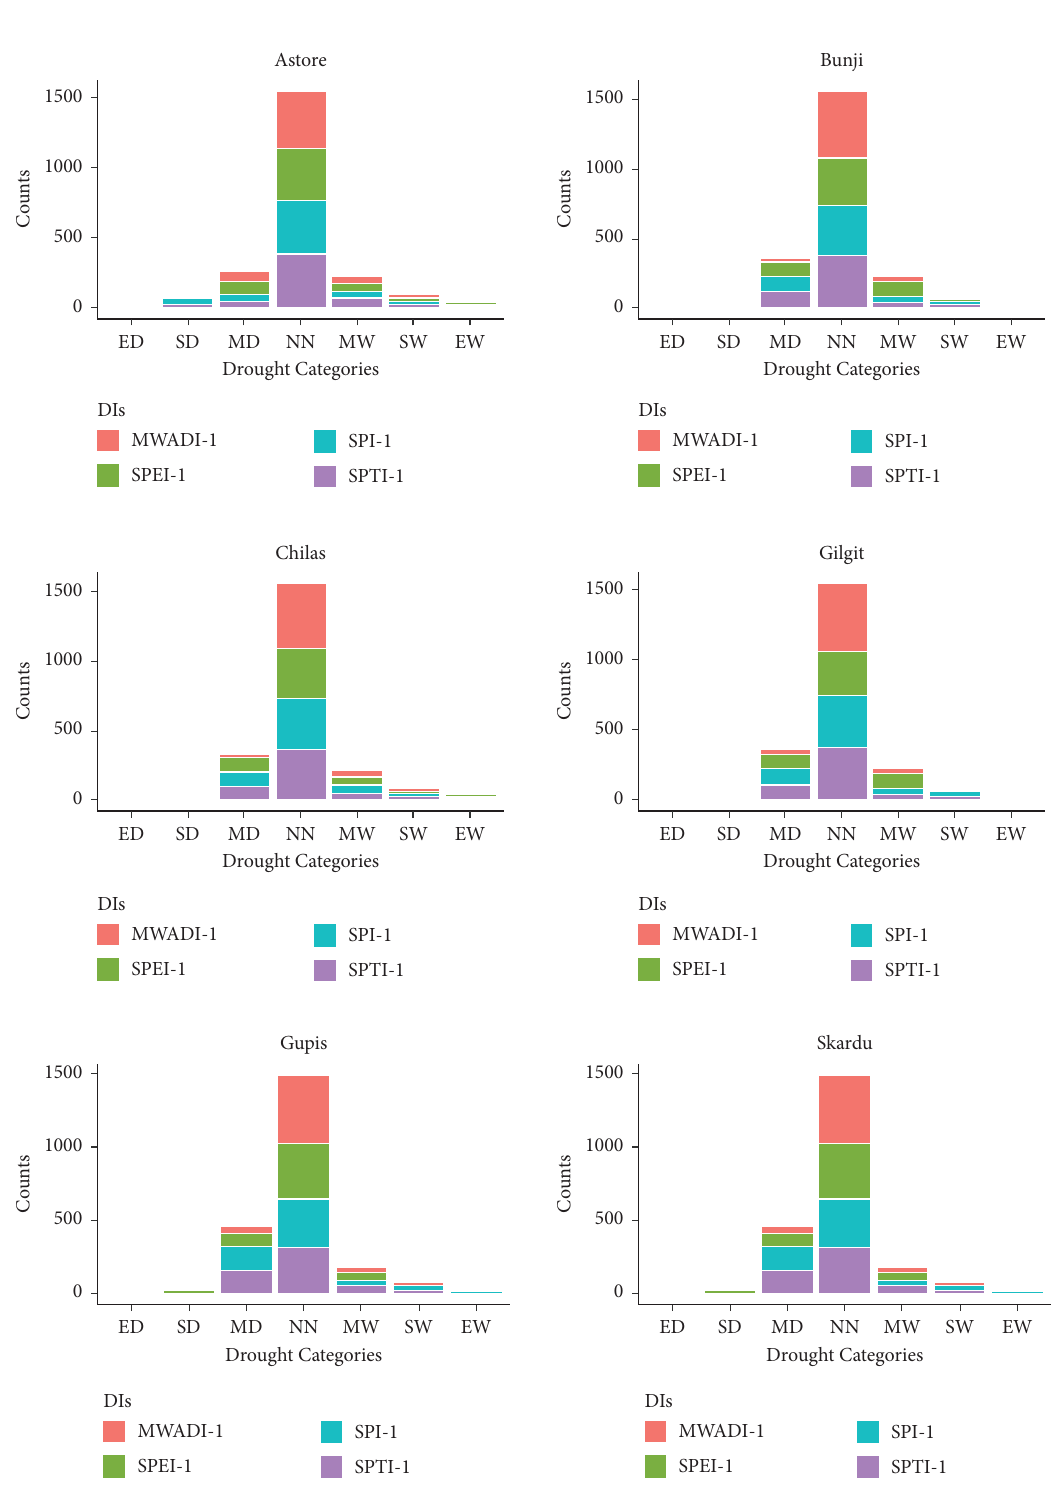
Figure 8: Count plots of MWADI-1, SPI-1, SPEI-1, and SPTI-1 at all